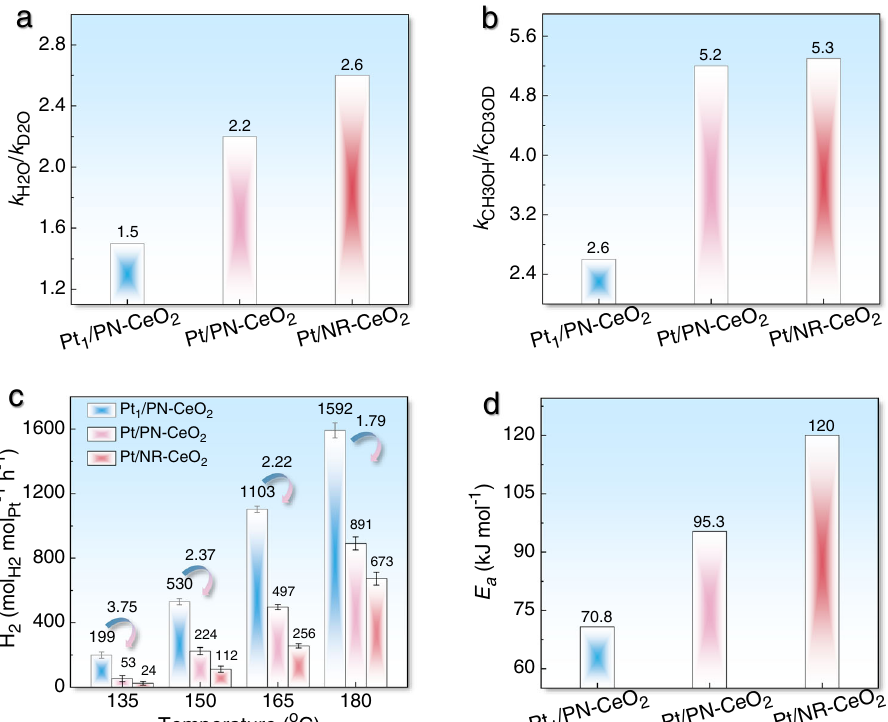
Fig. 5 | Kinetic analysis of dual-active sites for H 2 generation from methanol and H 2 O.a Ratios of H 2 generation rate from CH 3 OH/H 2 O to CH 3 OH/D 2 O. b Ratios of H 2 generation rate from CH 3 OH/H 2 O to CD 3 OD/H 2 O. c H 2 generation rates at